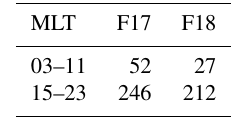
Table 1. Number of coincidences of F17 and F18 with the EISCAT Tromsø UHF radar during the two MLT